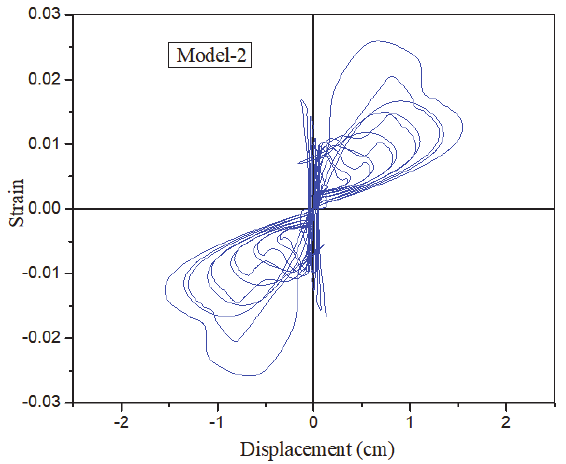
Figure 8: Strain Vs displacement on timber beam with 1.8 (m) length,